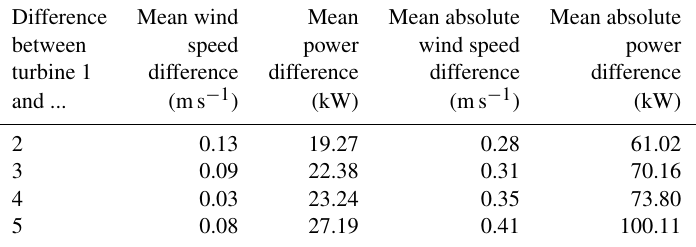
Table 3. Mean wind speed and mean power differences between one turbine and all other turbines at the Shagaya wind farm. Difference Mean wind Mean Mean absolute Mean absolute between speed power wind speed power turbine 1 difference difference difference difference and ...